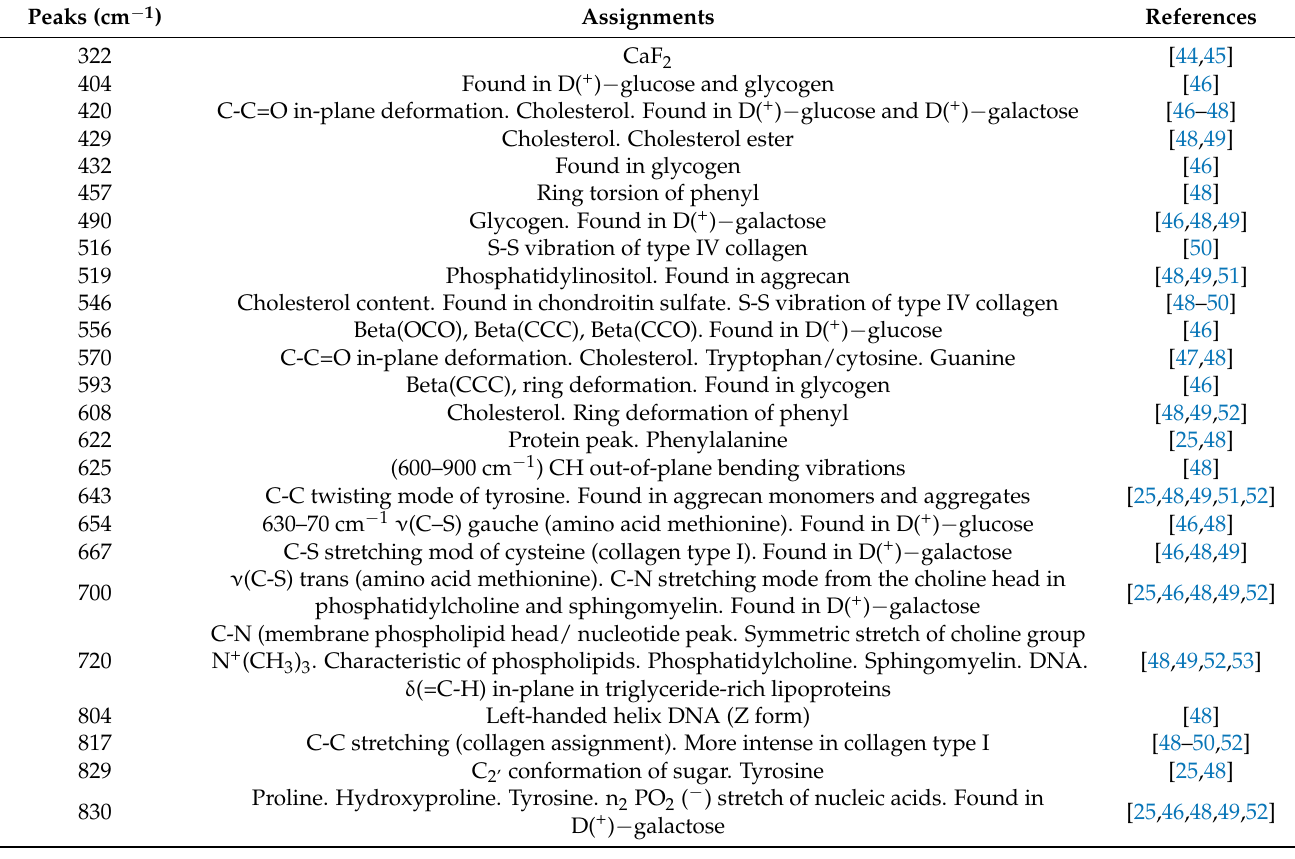
Table 1. Raman peaks detected in the average spectra from the decellularized matrices (unlabeled samples) acquired in the spectral region from 0 to 3800 cm − 1 . Known peaks from vibrational assignments are included (some with small shifts). Peaks (cm − 1 )